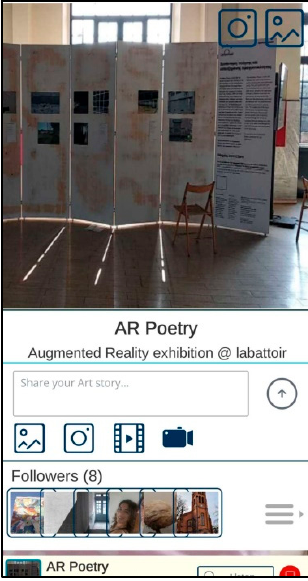
Figure 16. Created profile for the Poetry meets AR exhibition that was assigned the museum expert role.